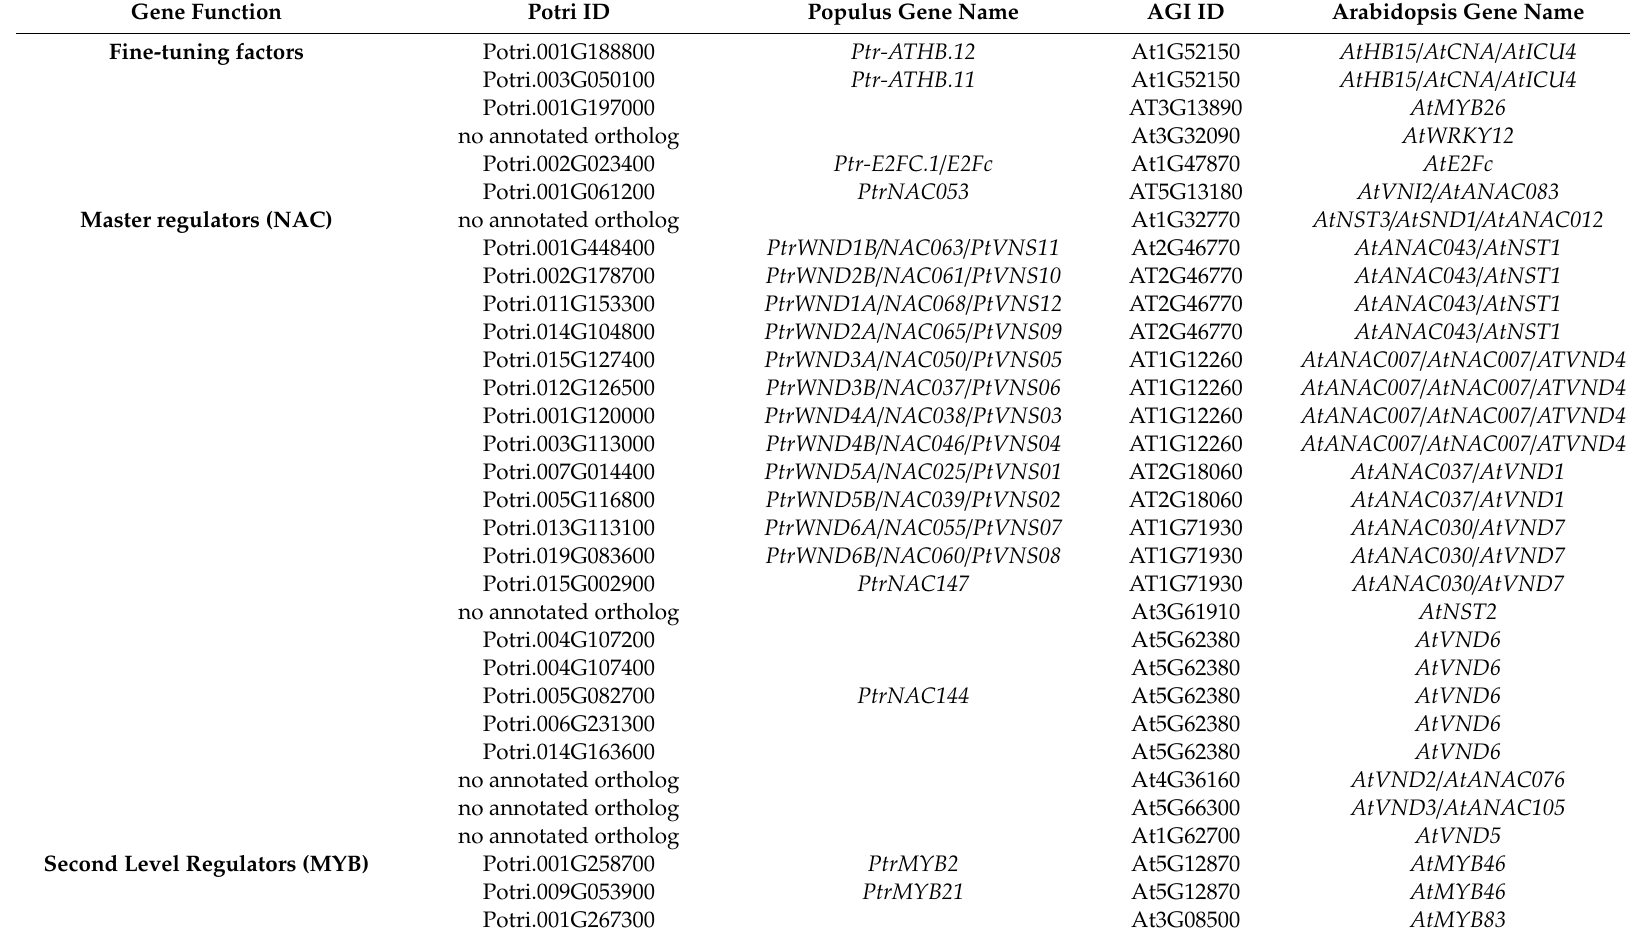
Table 1. List of orthologs of Arabidopsis thaliana wood-formation associated transcription factors present in Populus trichocarpa